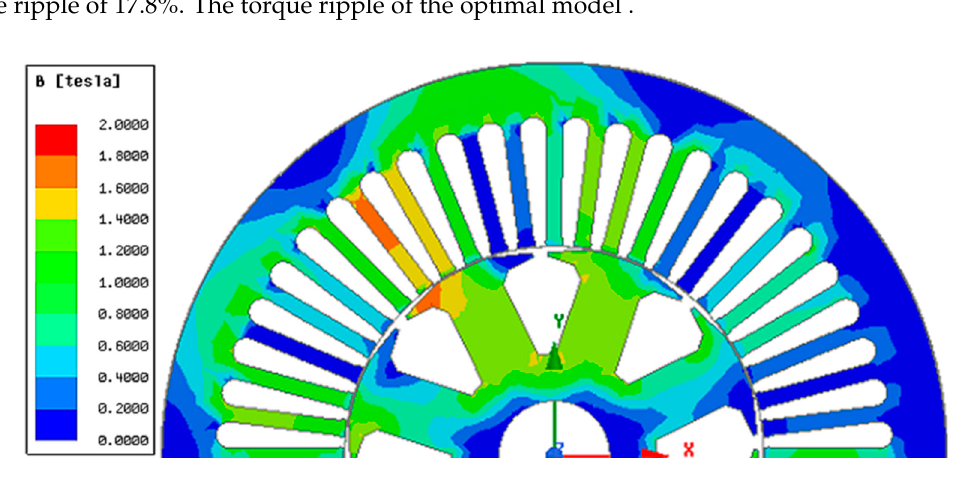
Figure 12. Field current (optimal model). Figure 13. Torque of the BL ‐ WRSM (optimal model). BL ‐ WRSM is significantly (61.8%) lower than the basic model. However, the torque of the optimal model is reduced by 13.74% as compared to the basic model. This decrease in torque is mainly due to the increase in air gap at the ending edge of the pole shoe. The torque of the optimal model is improved by optimizing the number of turns of the harmonic winding, as discussed in the following section.